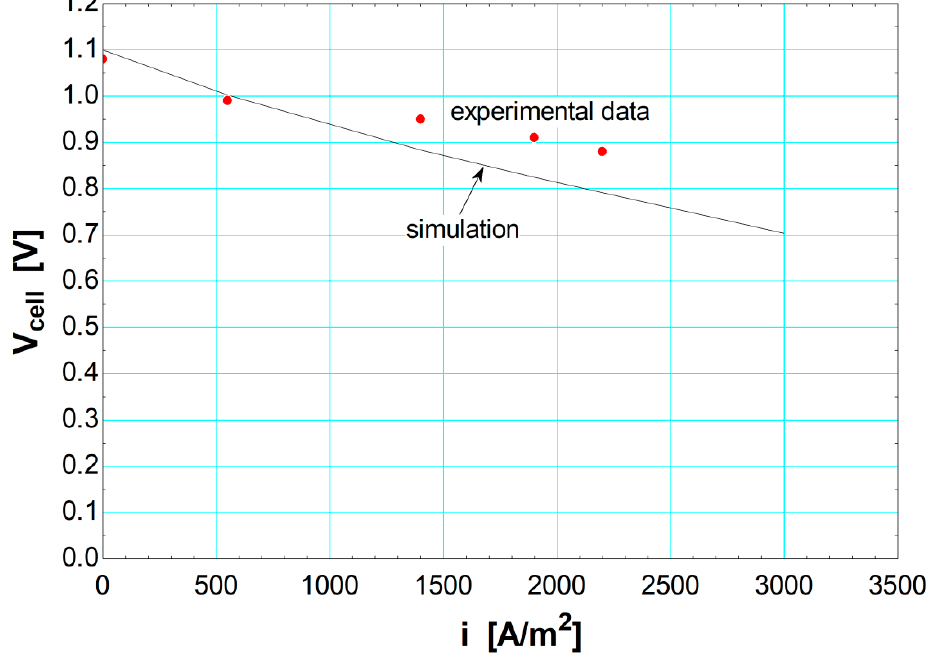
Figure 3. Validation of the modeled SOFC stack against literature data from [42].